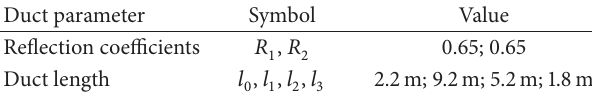
Table 1: Duct parameter value.